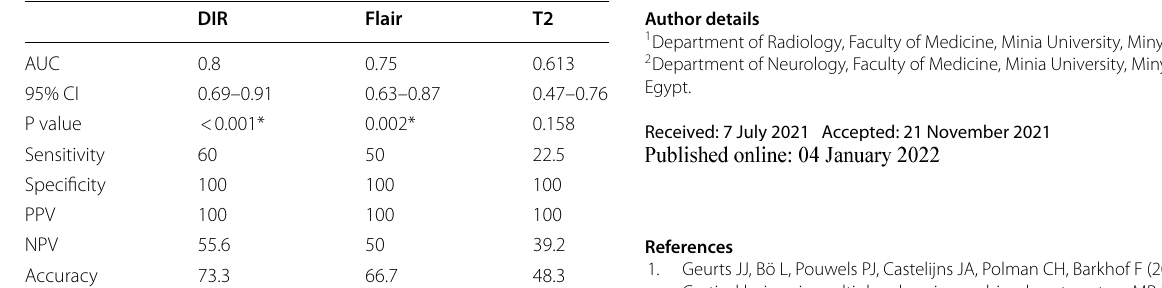
Significant level at P value < 0.0